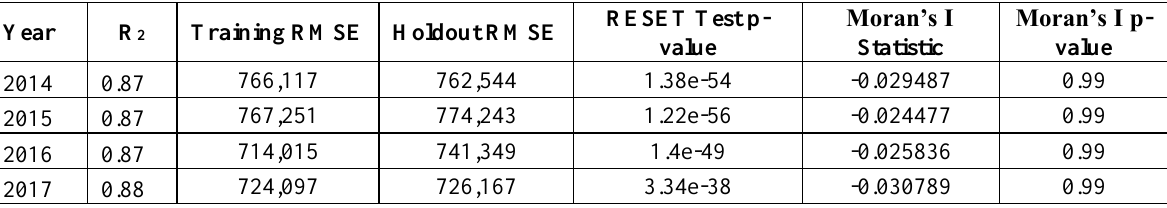
Table 6: Log Linear Model Summary and